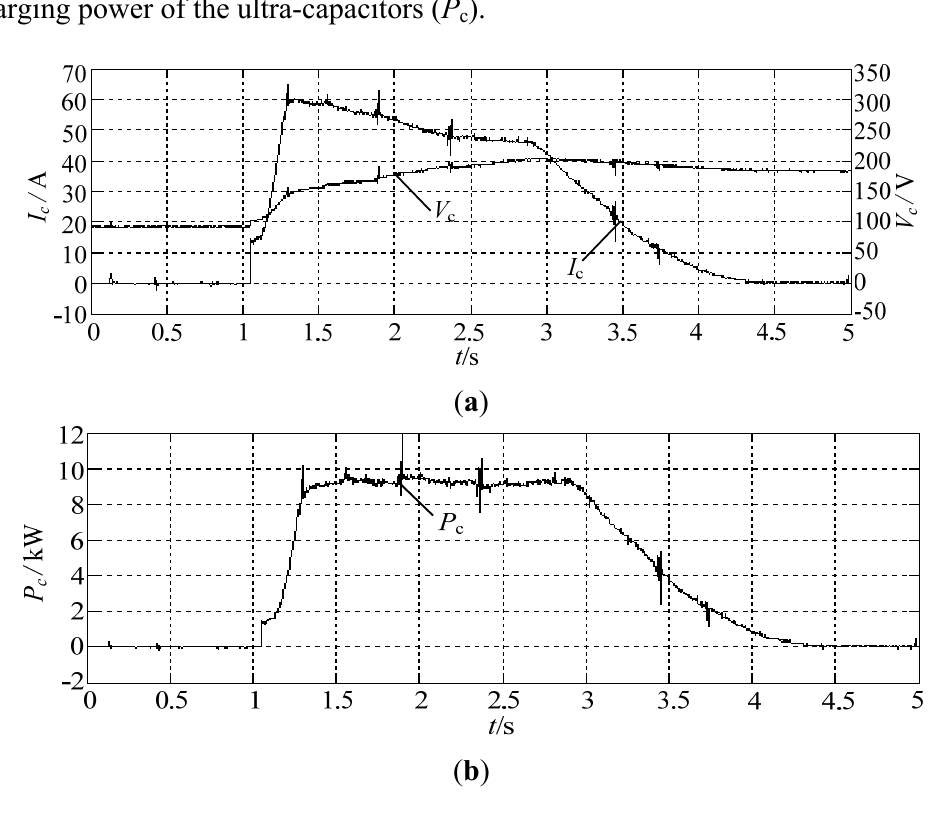
and charging current I ; c c c